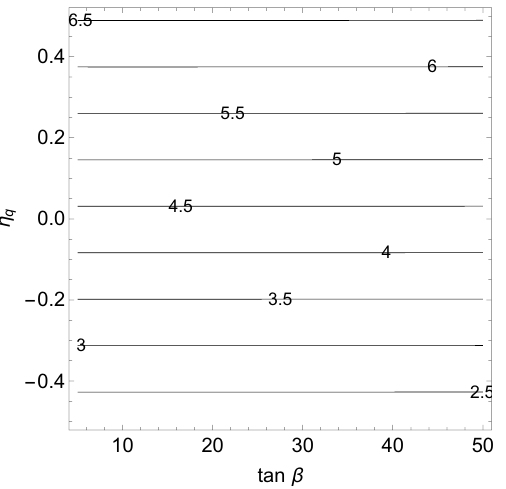
Figure 6 . Contour plot for the value of y (cid:22) =y s in the tan (cid:12) - (cid:17) q plane obtained from the data tables of [36] by taking (cid:17) b = (cid:0) 0 :